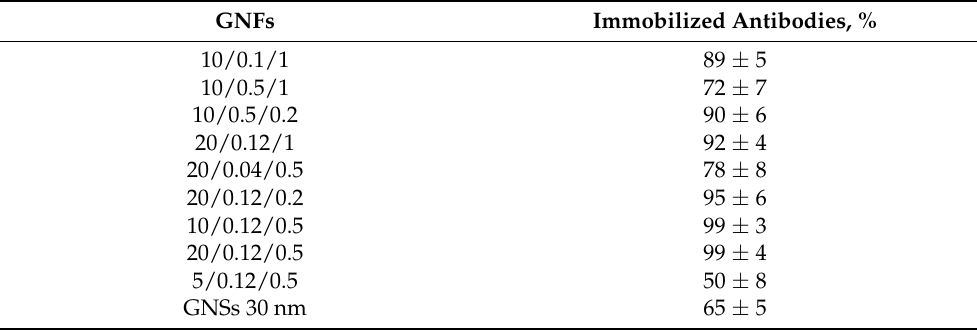
Table 3. Antibodies immobilized on the surface of gold nanoparticles by the adsorption method (for Ab4/cTnT as